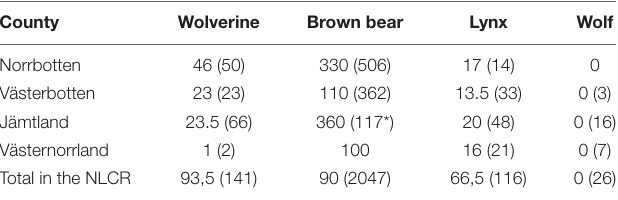
County Wolverine Brown bear